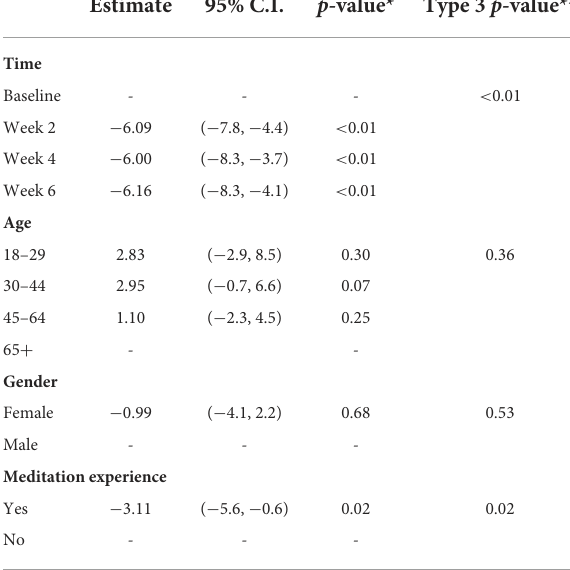
TABLE 3 Mixed effect model estimates, p -value, type 3 p -value for PROMIS scores. Estimate 95% C.I.